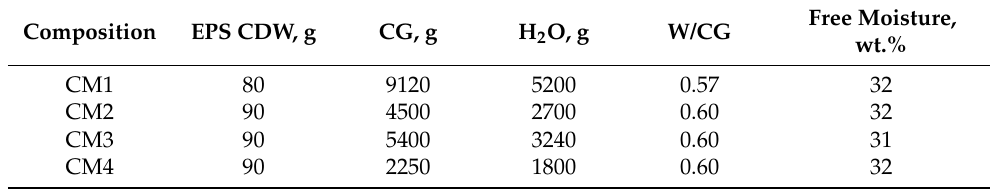
Table 3. Mixture compositions of EPS and gypsum samples made with the casting method. Composition